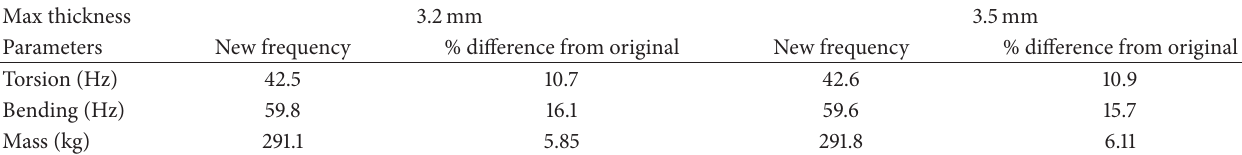
Table 3: Result comparison of using 3.2 mm and 3.5 mm thickness variable.